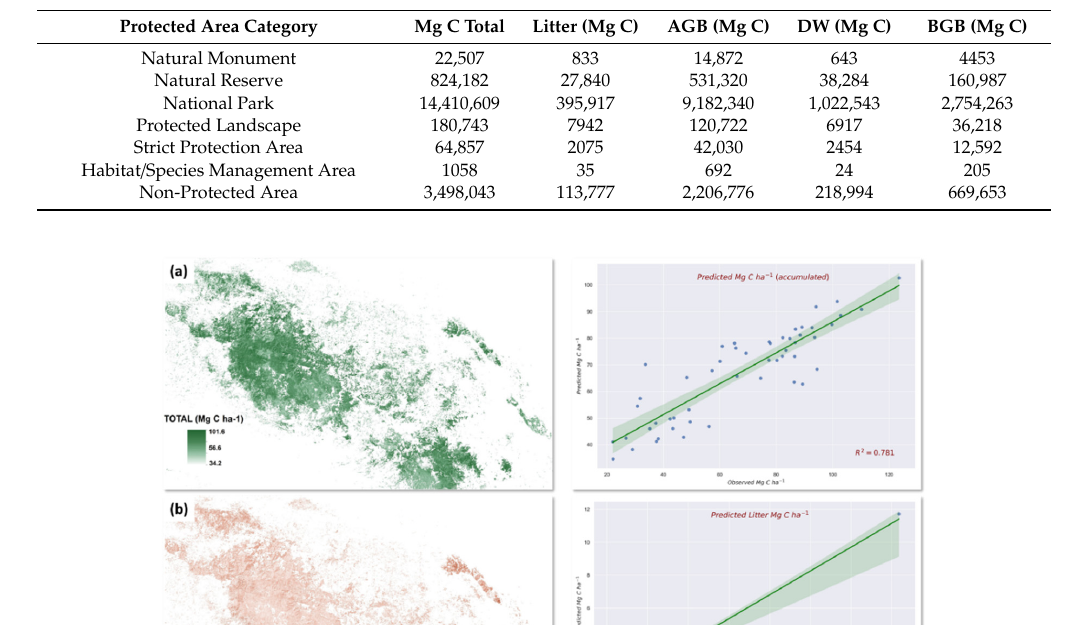
Table 7. Results of the accumulated carbon stocks and carbon stock models for the di ff erent pools in each protected area category.